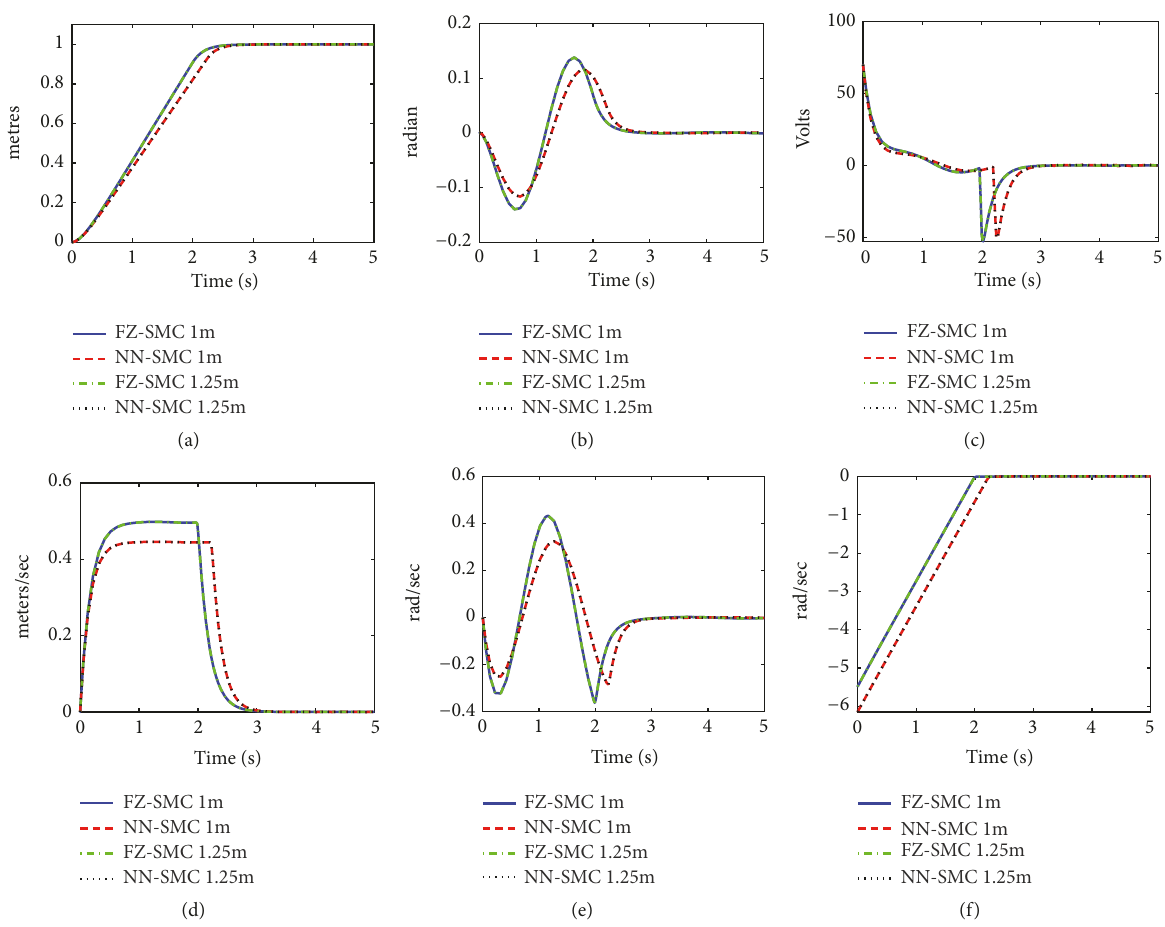
Figure 7: Responses with intelligent tuning algorithms. (a) Cart position. (b) Payload sway. (c) Control effort. (d) Cart velocity. (e) Sway angular velocity. (f) Sliding